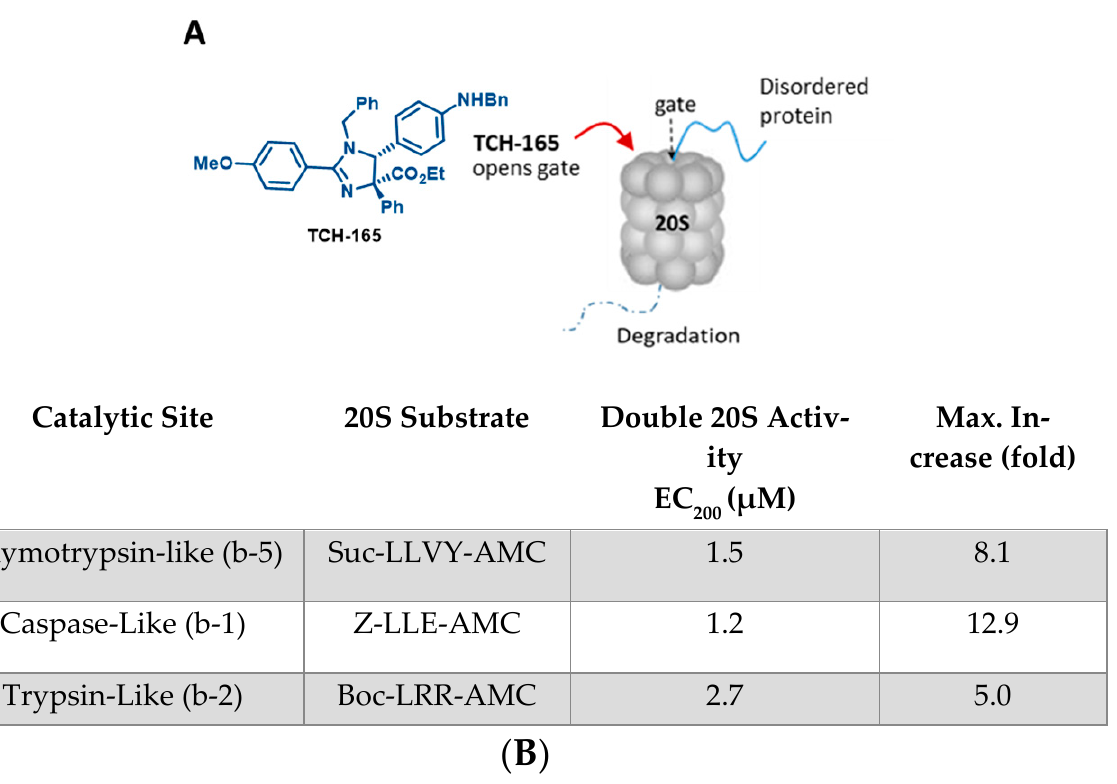
Figure 1. ( A ) Structure of TCH-165 and its proposed model of α -ring binding, allowing the gate to open for easy access of disordered proteins to the internal proteolytic sites; ( B ) EC 200 values of TCH-165 and maximum fold enhancement of 20S activities for each of the three catalytic sites.